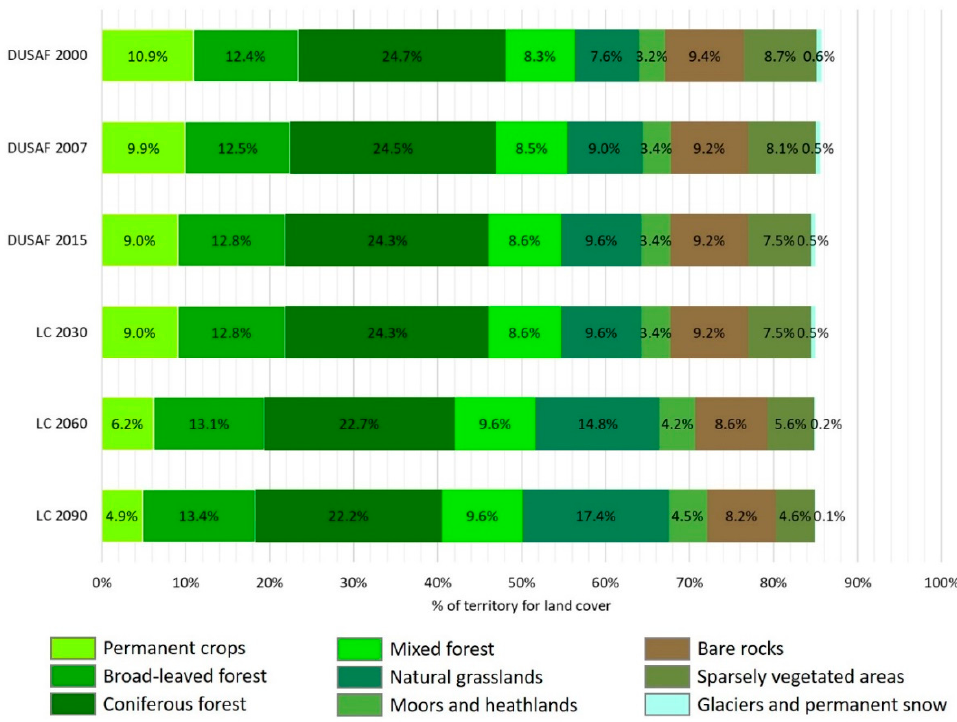
Figure 10. Most significant land cover classes at each observed (DUSAF) and simulated (LC) epoch.